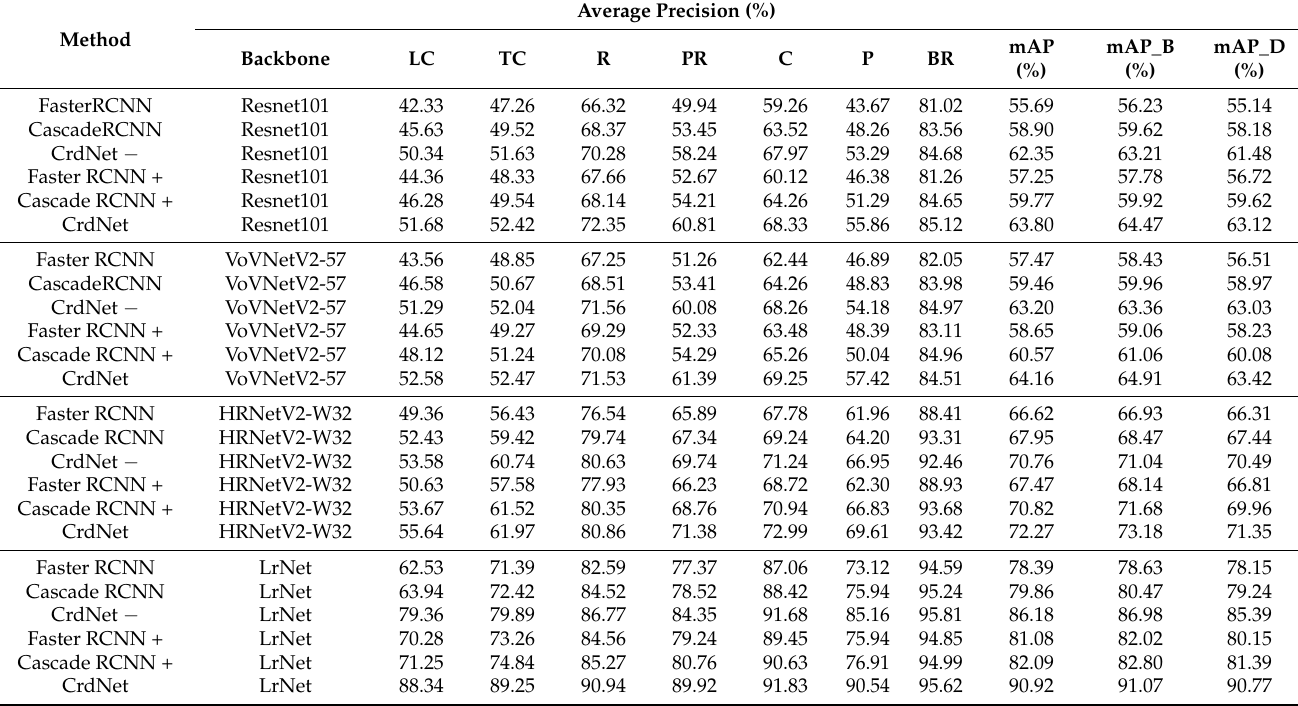
Table 3. Performance comparison of HL2019 test set. mAP_B and mAP_D, mean average precision of light and dark images, respectively. + indicates Faster RCNN and Cascade RCNN use MSARM. − means CrdNet utilizes FPN to generate anchors.